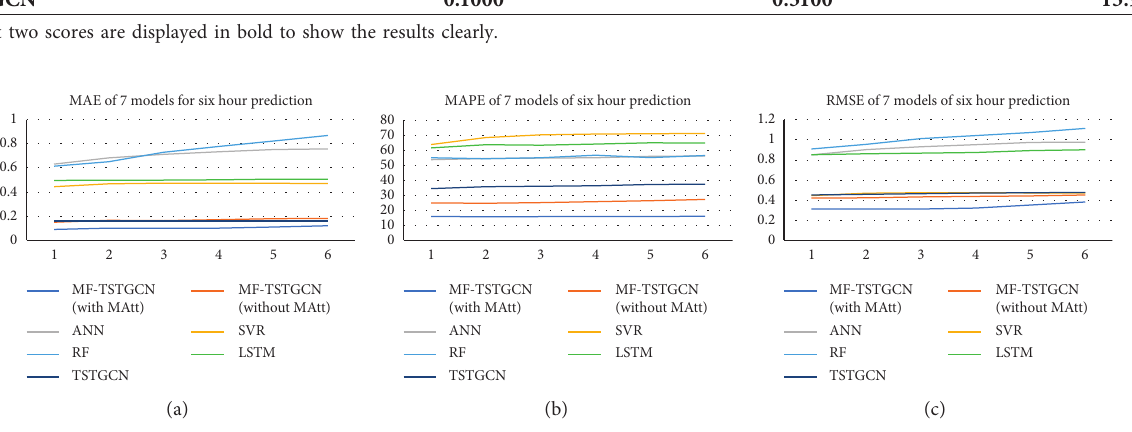
Figure 2: Execution effect of 7 methods for six-hour prediction. (a) MAE. (b) MAPE. (c) RMSE.